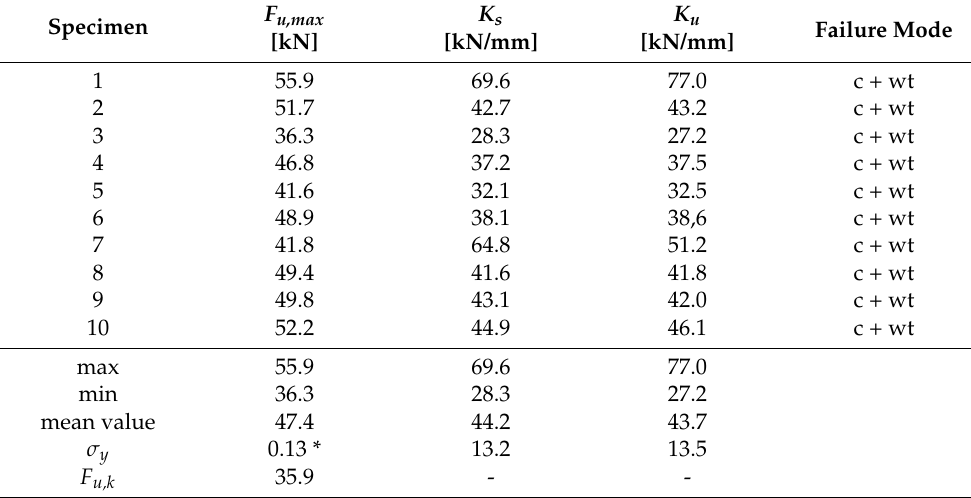
Table 2. Failure load and stiffness parameters for experimental series clc8160. Specimen